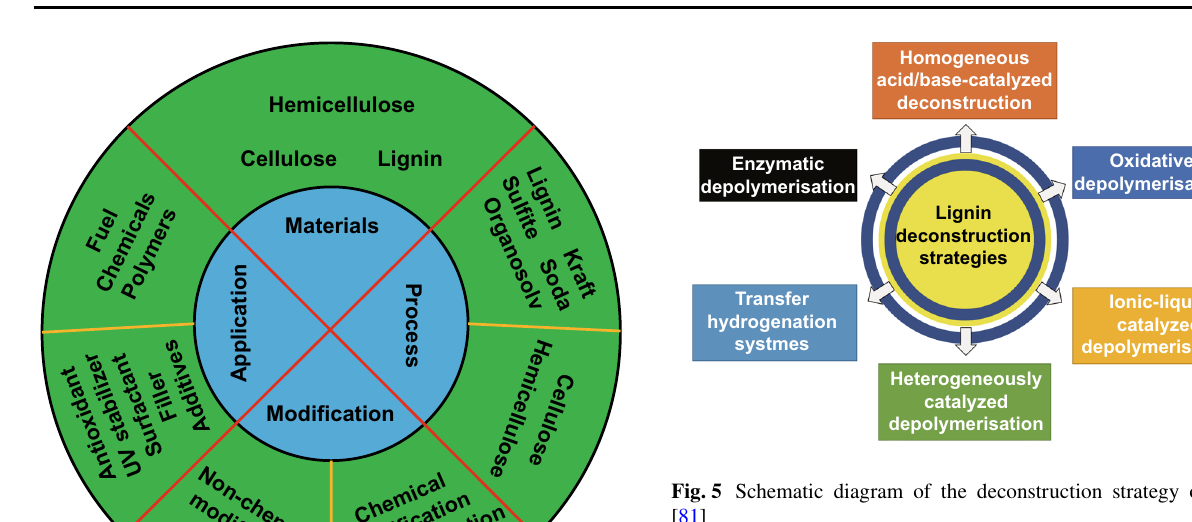
Fig. 5 Schematic diagram of the deconstruction strategy of lignin